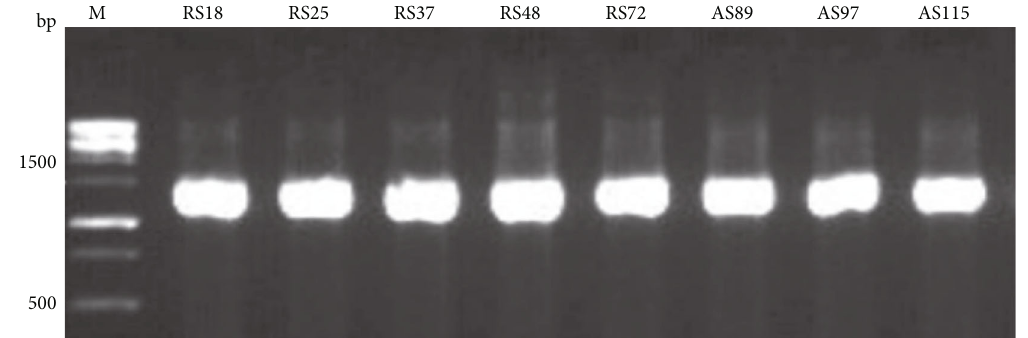
Figure 2: PCR ampli fi cation of the 16S rRNA from the isolated Streptomyces on a 0.8% agarose gel. M: marker. RS18, RS25, RS37, RS48, RS72, AS89, AS97, and AS115 refer to the isolates code denoted in the tables. Table 5: E ff ects of di ff erent enzymes on the antibacterial activities of metabolites of the stains. Enzymes